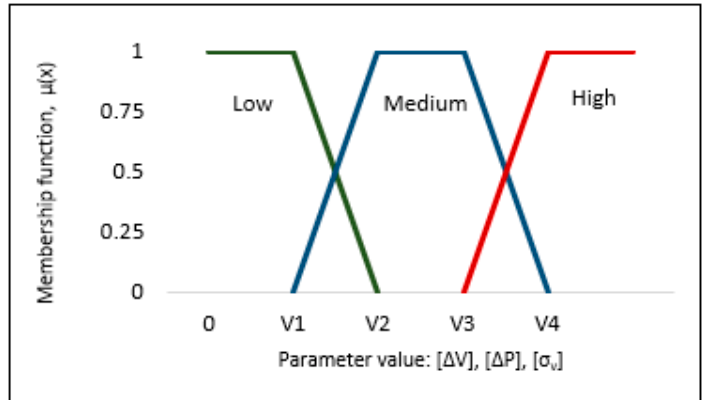
Figure 3. Classification of failures (Fuzzy variables).